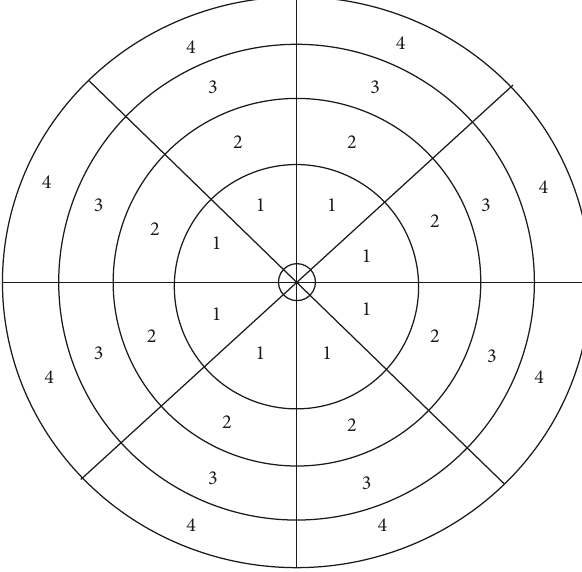
Figure 10: The basic principle of DEROUS-based